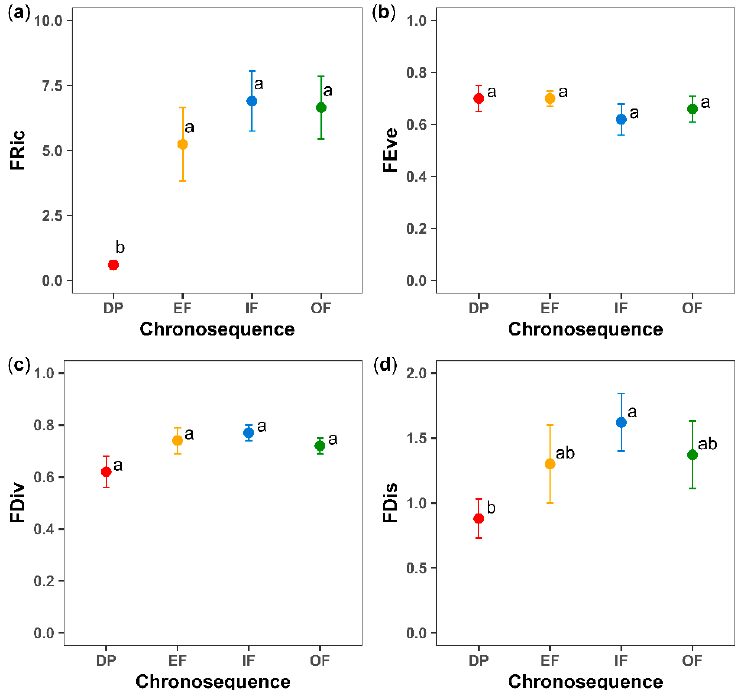
Figure 3. Means ± SE for: ( a ) functional richness (FRic), ( b ) functional evenness (FEve), ( c ) functional divergence (FDiv), and ( d ) functional dispersion (FDis) for the different successional categories (DP, degraded pasture; EF, early forest; IF, intermediate forest; OF, old-growth forest or mature forest). For each index, values between successional categories followed by the same letter do not differ statistically according to Fisher’s LSD post hoc test ( p < 0.05).